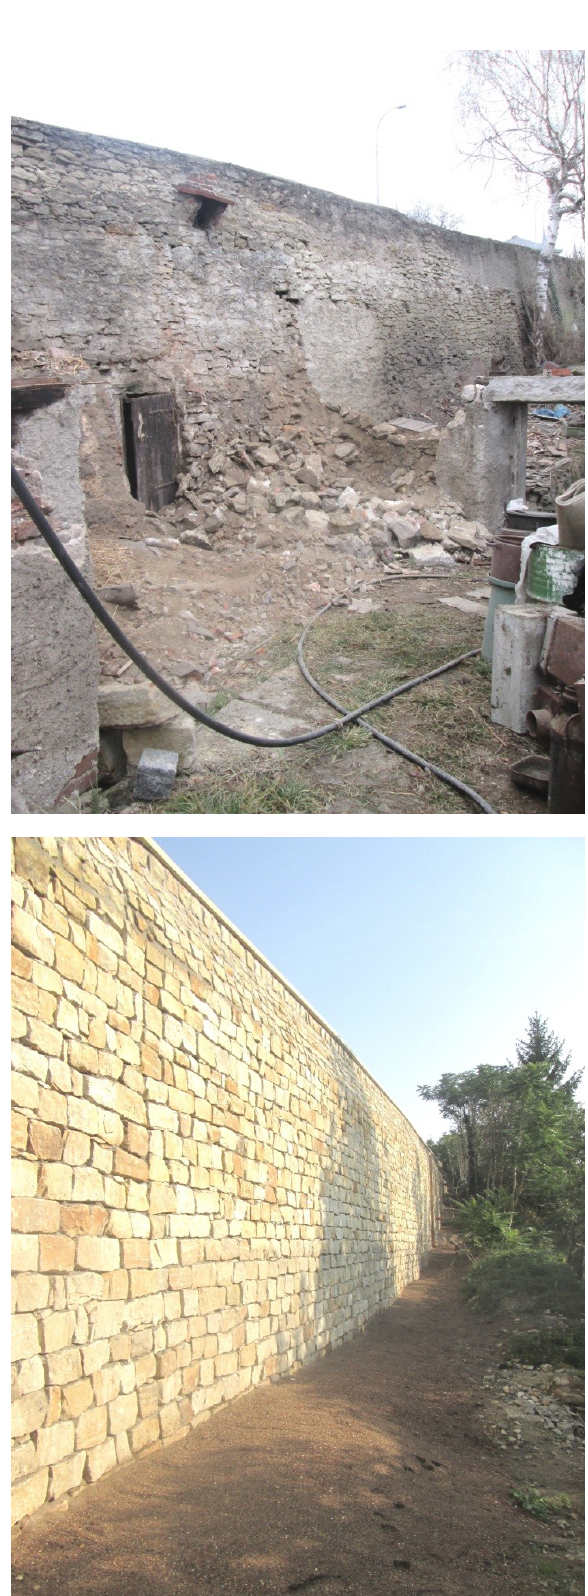
Figure 3. Structural condition comparison: the old (top) and the new wall